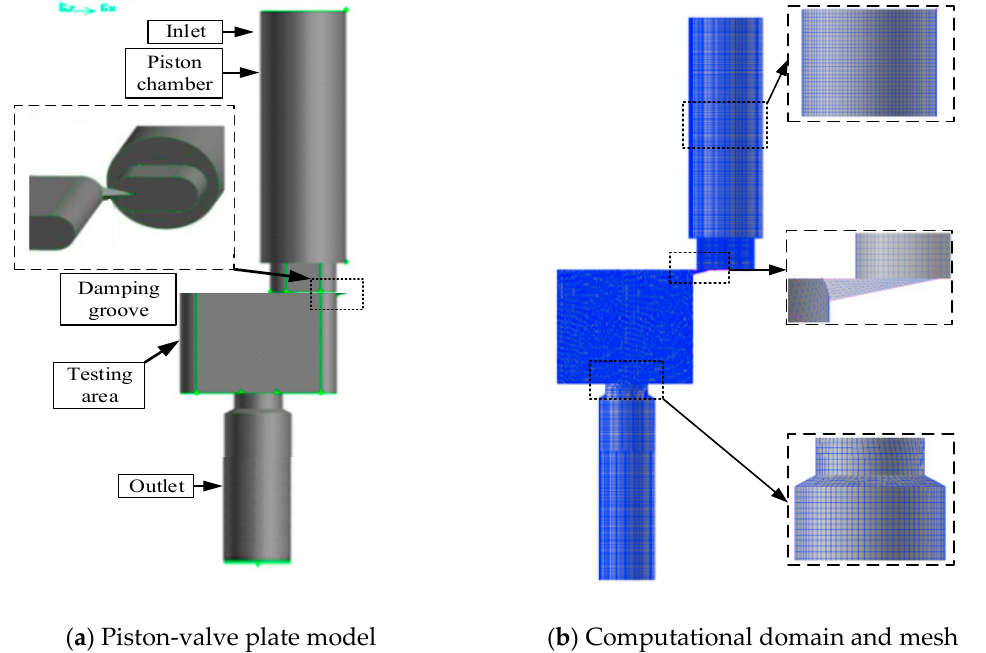
Figure 4. Piston-valve plate model and computational mesh